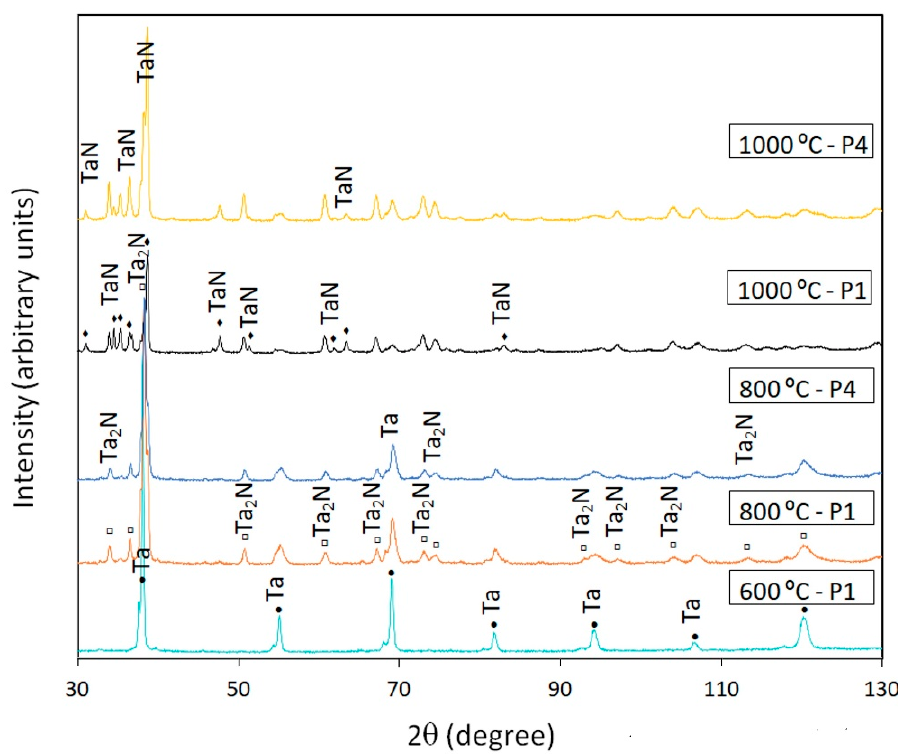
Figure 6. XRD patterns obtained for Ta powders nitrided under flowing NH 3 (1.14 mm · s − 1 ) where P1 refers to position 1 nearest to gas inlet and P4 refers to position 4 closest to gas outlet.